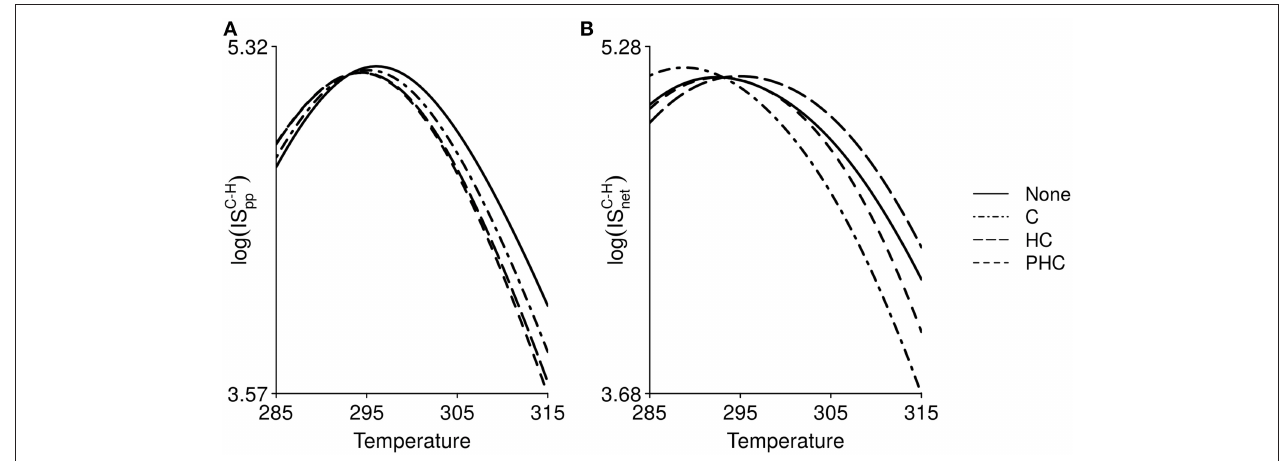
FIGURE 5 | Effect of temperature (in Kelvin) on, (A) , interaction strength per population, IS C − H pp , and, (B) net interaction strength, IS C − H net , between carnivores and herbivores, when organisms body mass decreases with temperature due to the temperature-size rule. Four scenarios are simulated: no TS response in either species (None), only carnivores follow a TS response (C) , herbivores and carnivores follow a TS response (HC) and the three trophic levels follow a TS response